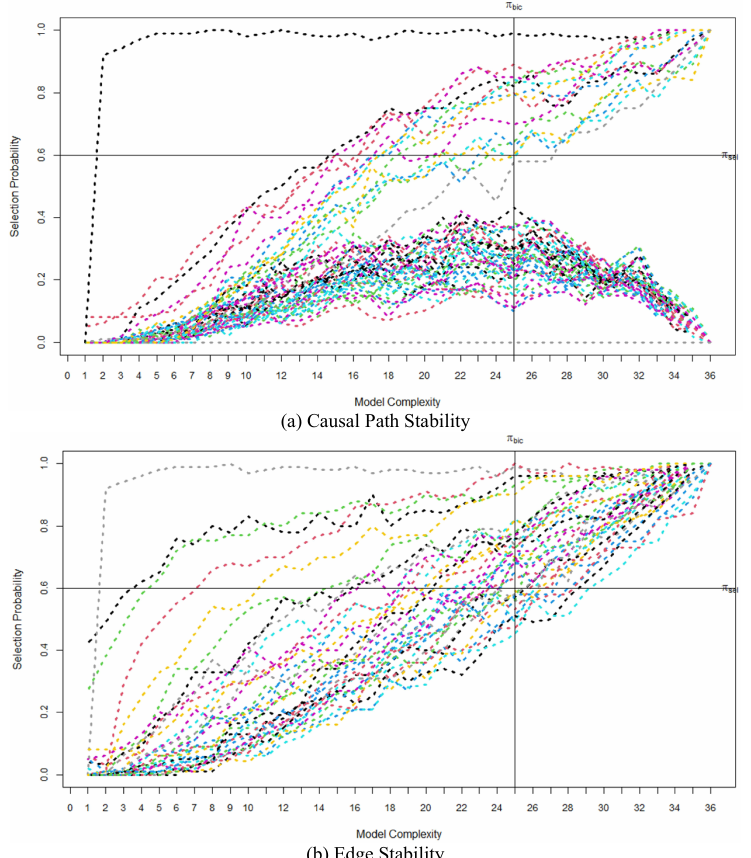
Fig. 3. The S3C-Latent (a) Causal Path Stability and (b) Edge Stability. Details on how to read these graphs can be found in our study [13]